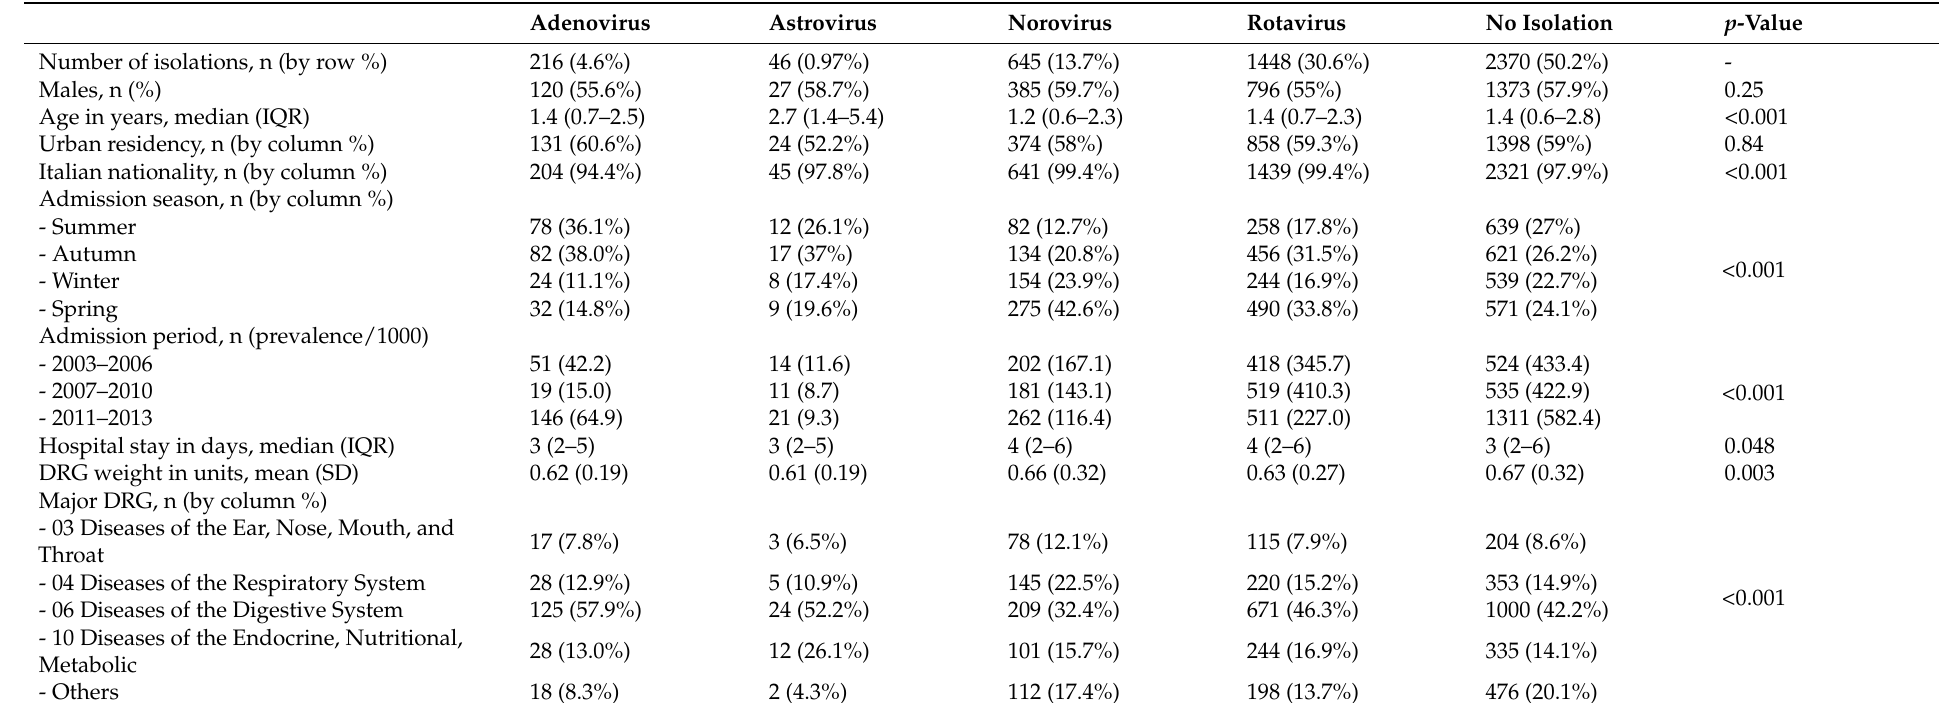
Table 2. Epidemiological factors and clinical features in hospitalized children according to virus